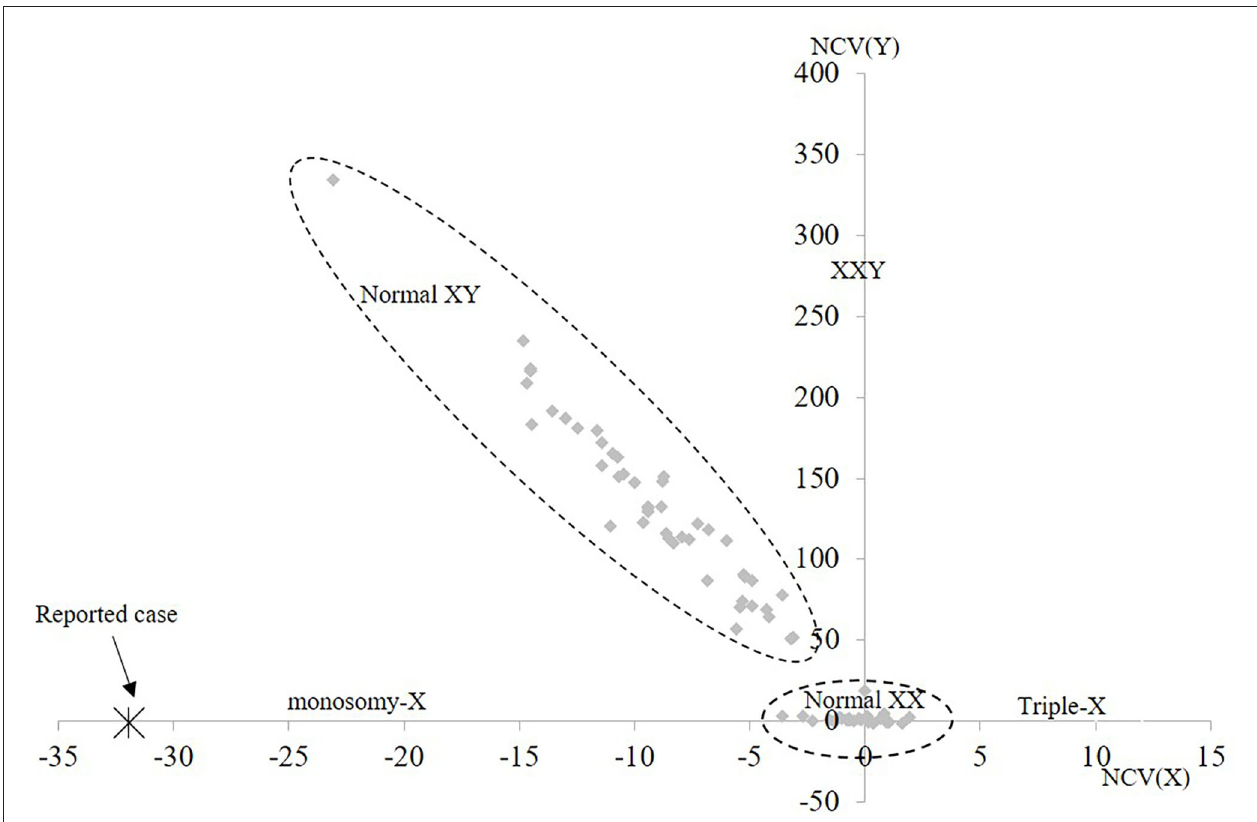
FIGURE 1 | Cell-free NIPT result for chromosome X. The 1st axis represents the normalized level of X-chromosomal material and the 2nd axis represents level of Y-chromosomal material detected. The normal range for female euploid samples (Normal XX) and male euploid samples (Normal XY) are marked by the dotted lines. The cfNIPT result for the reported case is marked with an enlarged X. NCV, Normalized Chromosome Value (for chromosome X and chromosome Y,